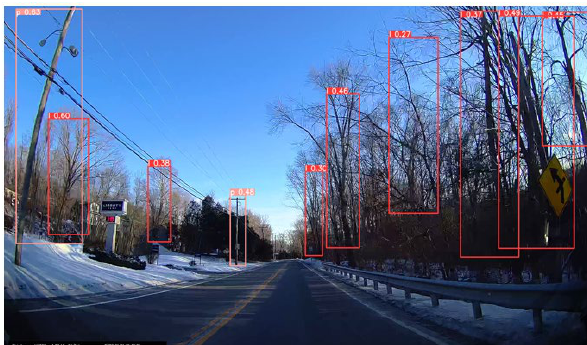
Figure 8: Detection of tree trunk and pole on an independent